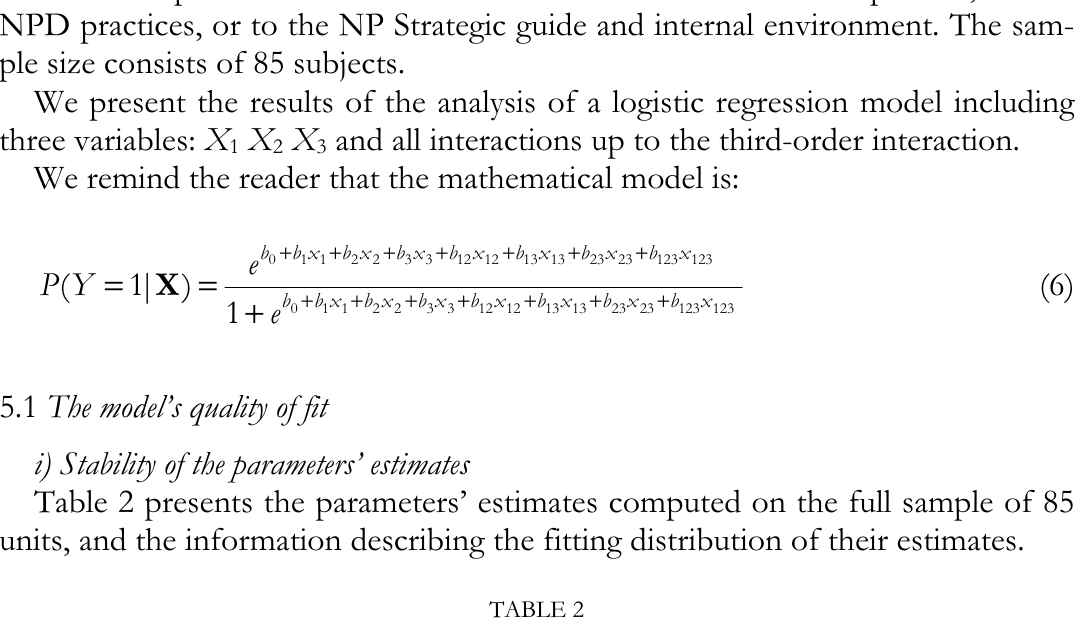
Quality of the model’s fit: stability of the parameters’ estimates Stability of the parameters’